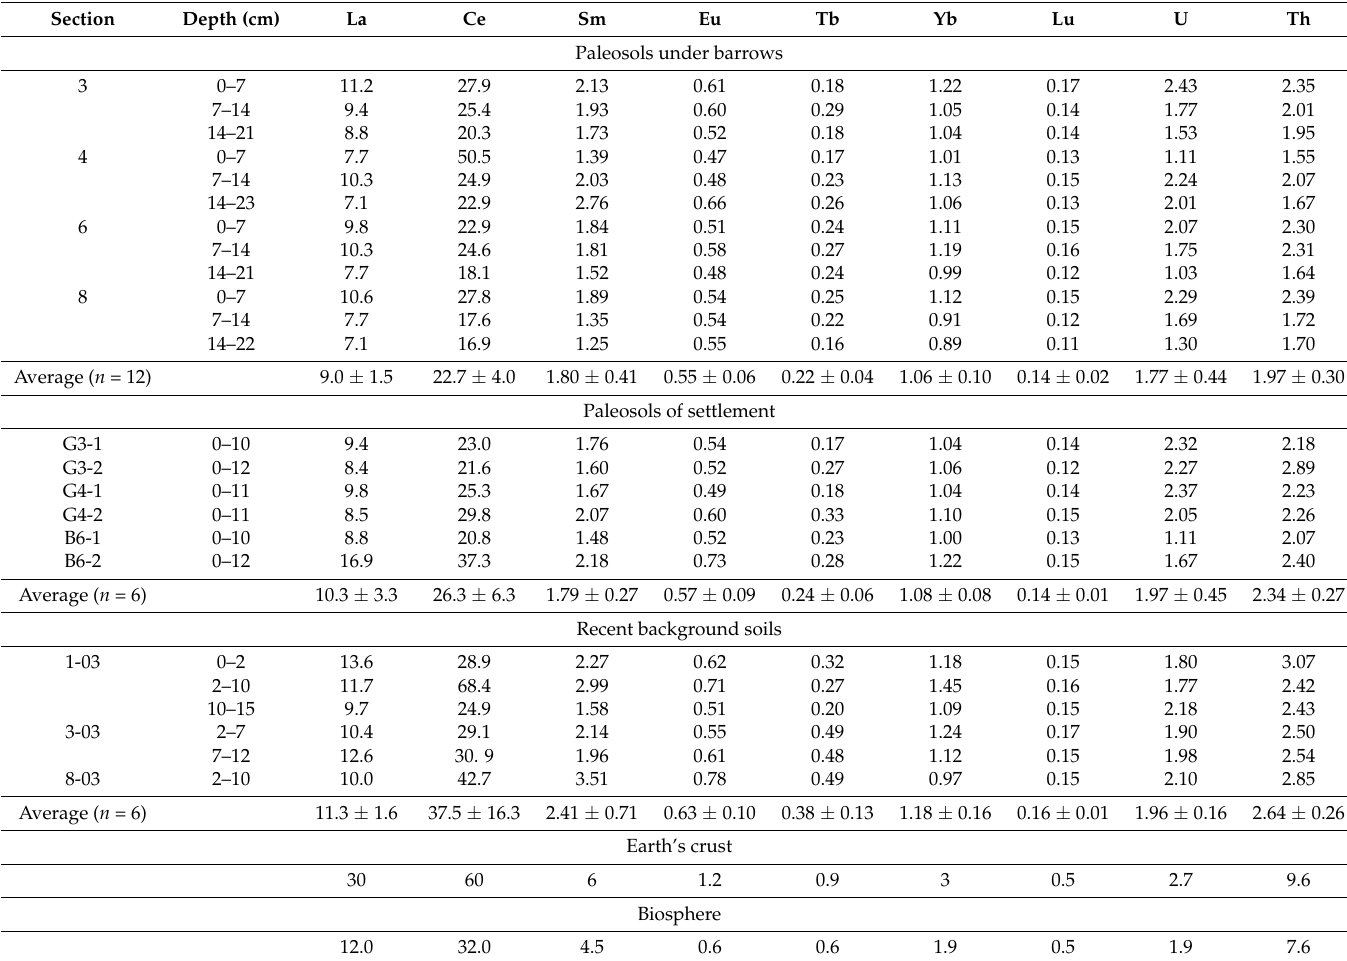
Table 2. The content of some lanthanides and actinides in the humus horizons of paleosols and recent soils of the forest-steppe zone of the Southern Urals in the earth’s crust [47] and the biosphere [48], mg · kg − 1